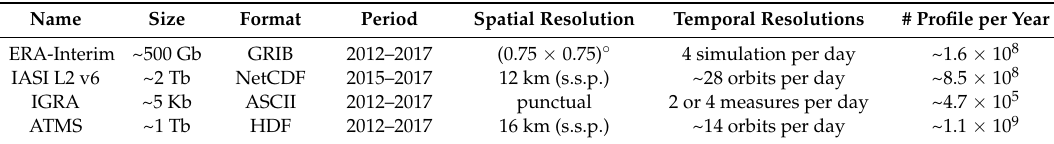
Table 2. Main characteristics of the data considered in this